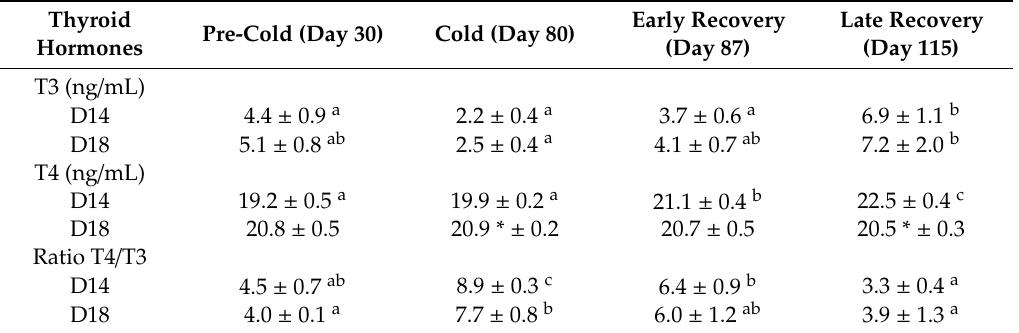
Table 1. Thyroid hormones levels of juvenile gilthead sea bream throughout temperature fluctuation feeding di ff erent dietary lipid